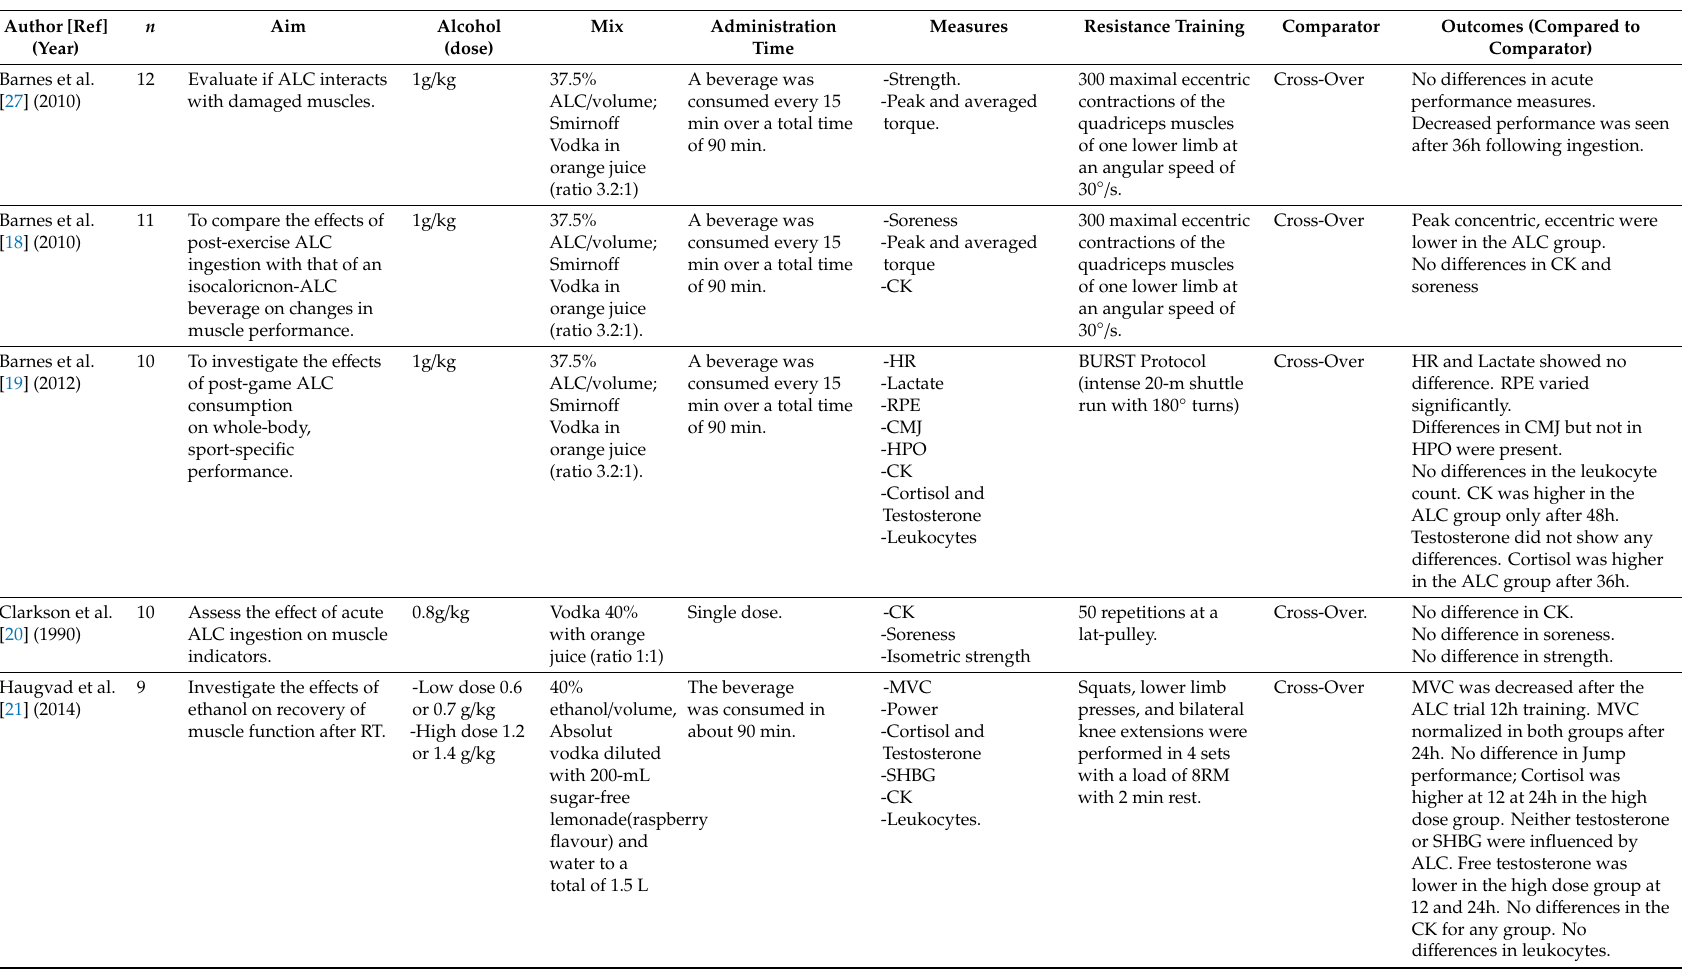
Table 1. Descriptive characteristics of the retrieved